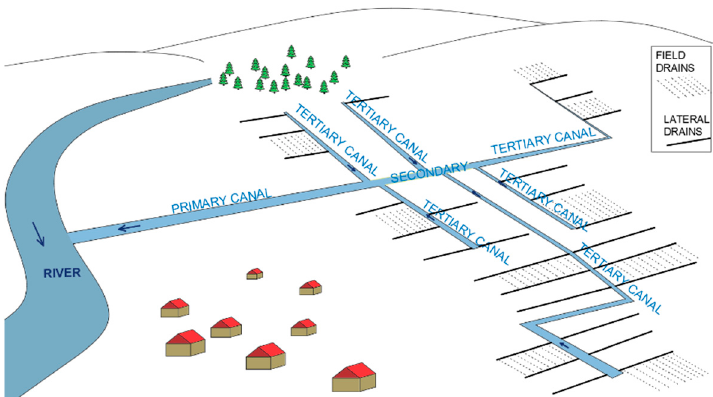
Figure 1. Typical scheme of drainage canal network.